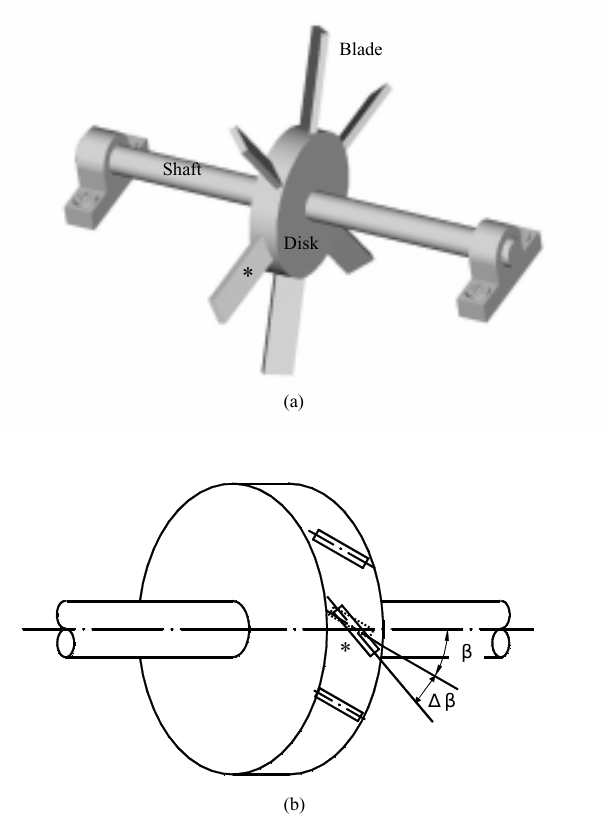
Fig. 1. (a) A shaft-disk-blade rotor with a mistuned (asterisked) blade, and (b) the mistuned